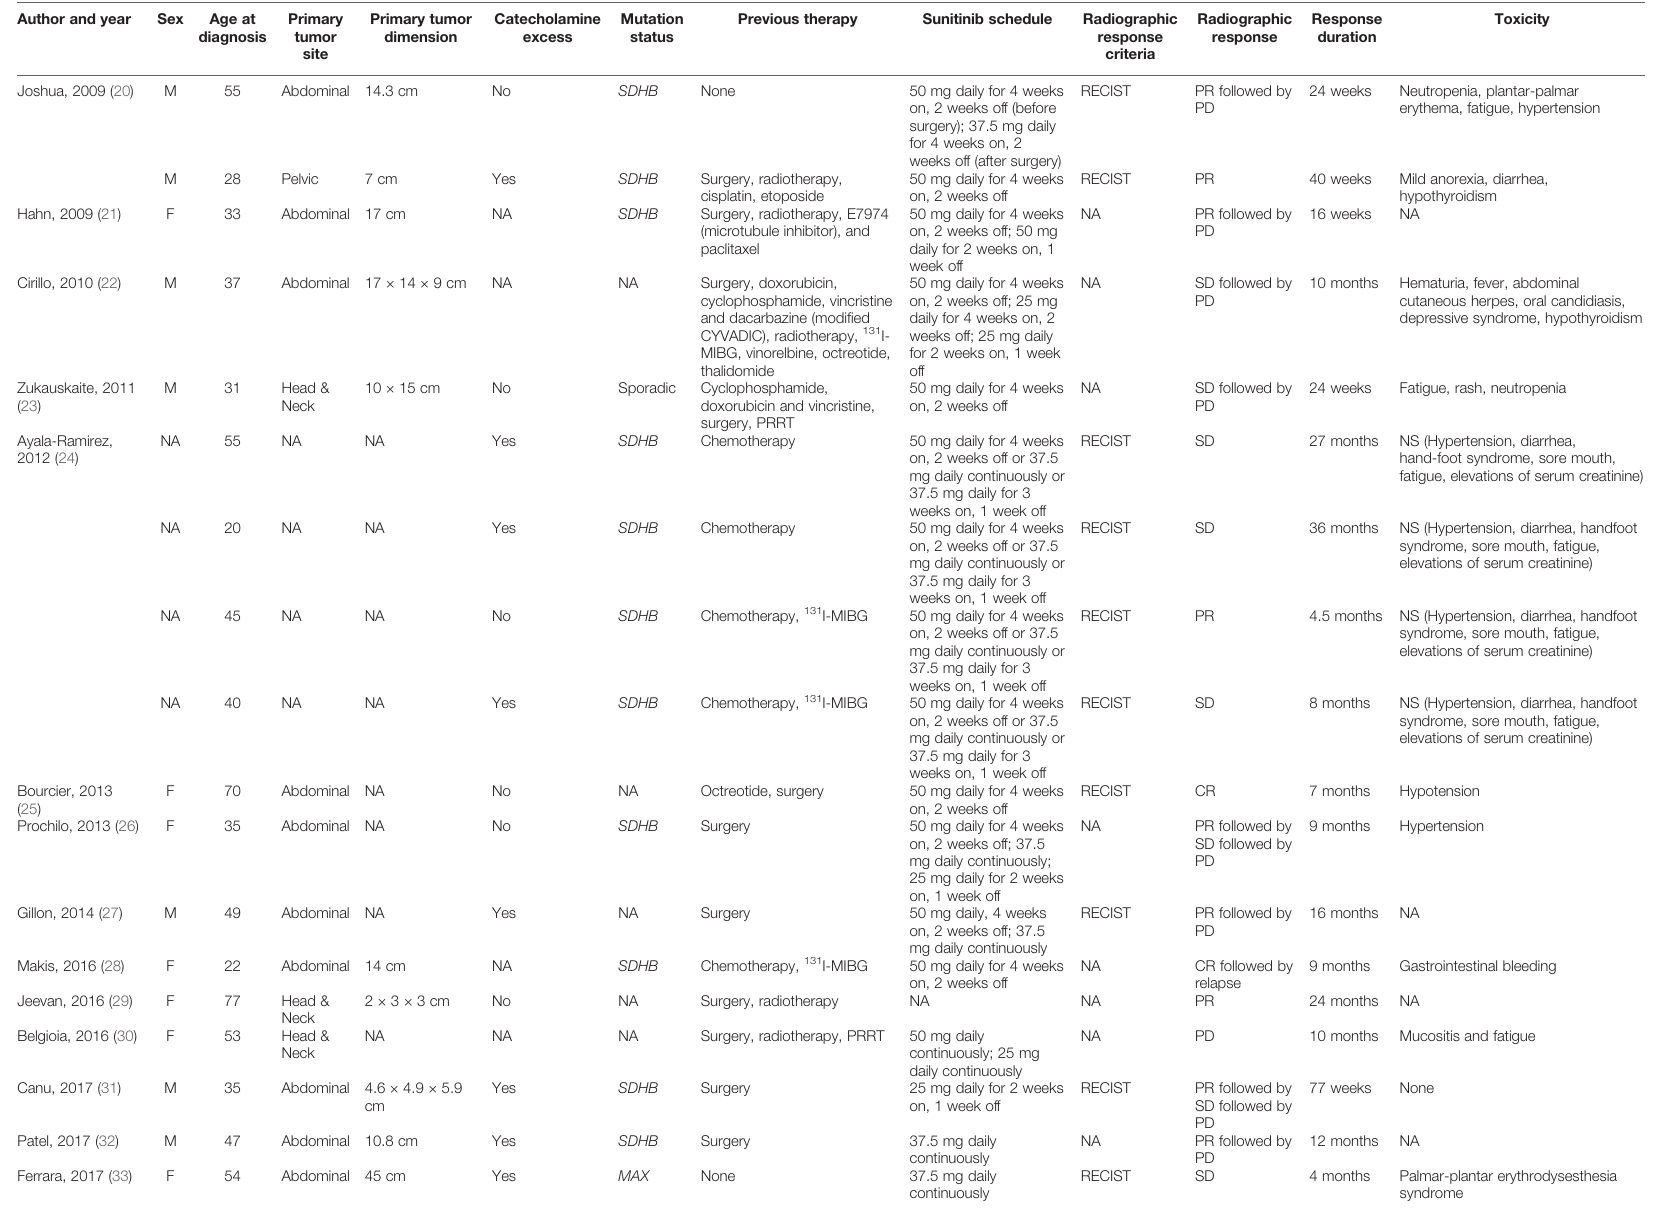
TABLE 1 | Response to sunitinib in patients from 25 selected case reports, case series, and clinical